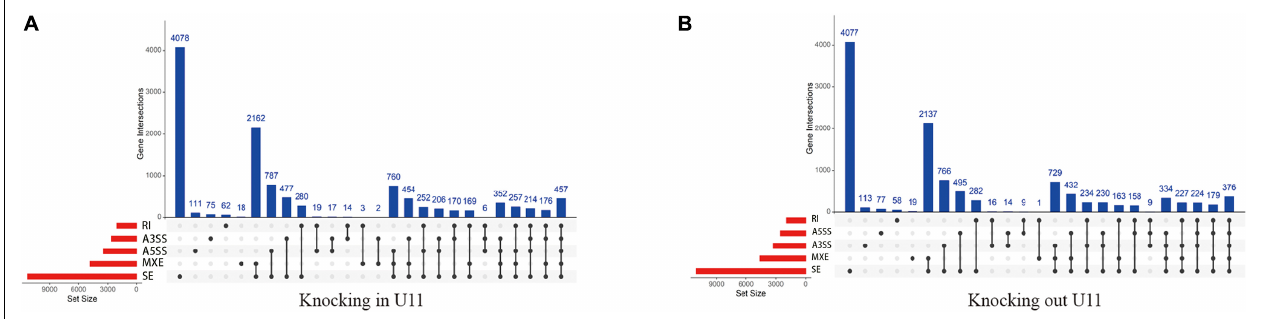
FIGURE 5 | The identification of alternative splicing events. (A,B) Up-set plots of significant alternative splicing events upon knockout and overexpressed U11 in T24 cells. Skipped exon (SE), alternative 5 (cid:48) splice site (A5SS), alternative 3 (cid:48) splice site (A3SS), mutually exclusive exons (MXE), and retained intron (RI).